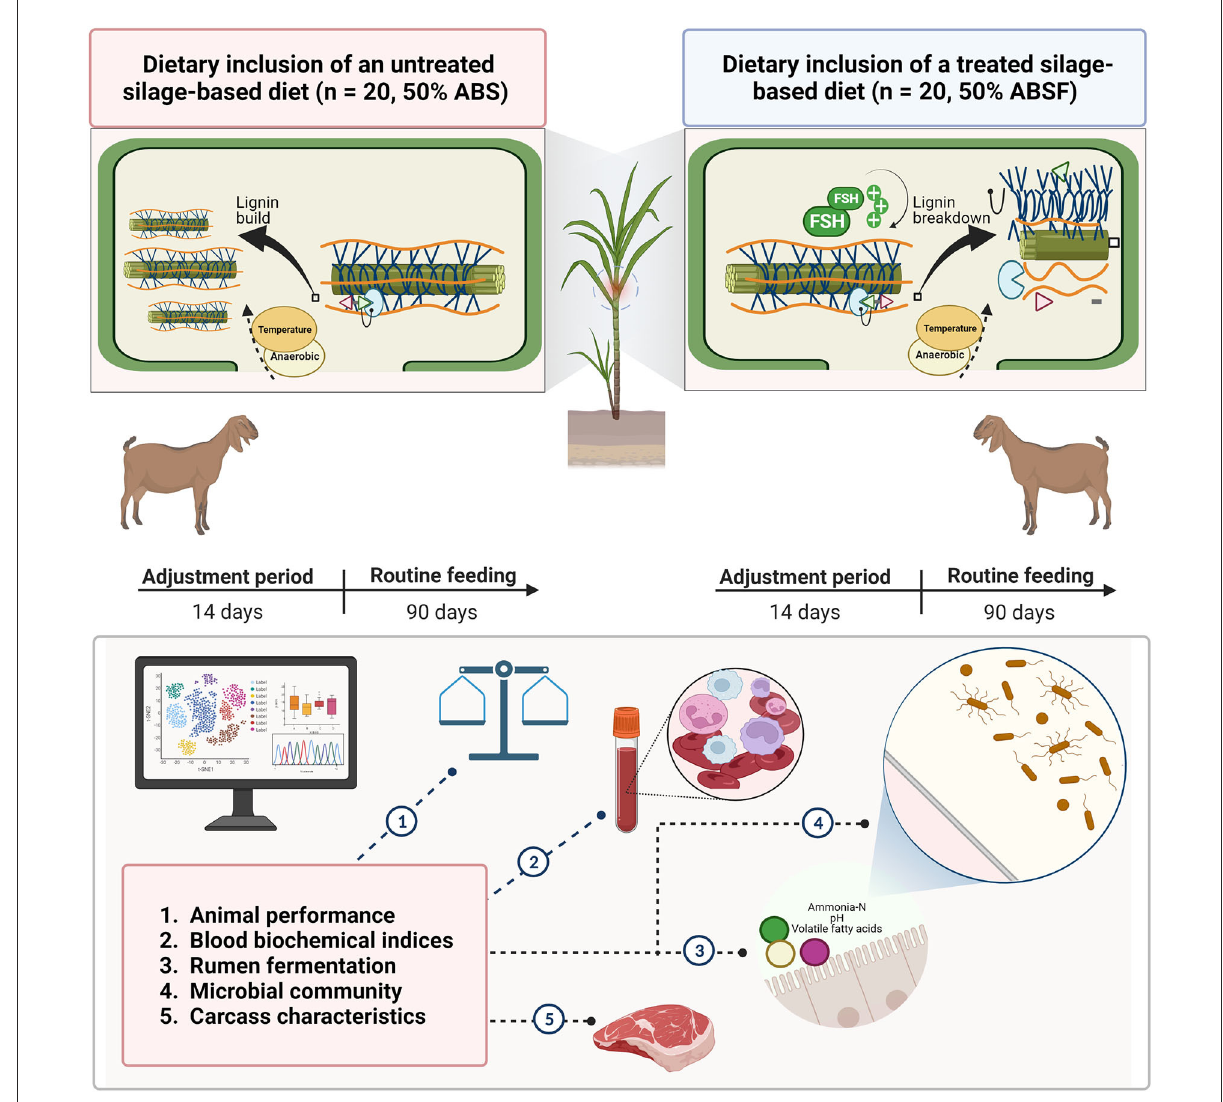
FIGURE1 A 90-day routine feeding was conducted to investigate the feasibility of using anthocyanin-rich black cane silage (ABS) as a functional feed resource vs. anthocyanin-rich black cane with 0.03% FSH (ABSF) in healthy crossbred Thai-native Anglo-Nubian male